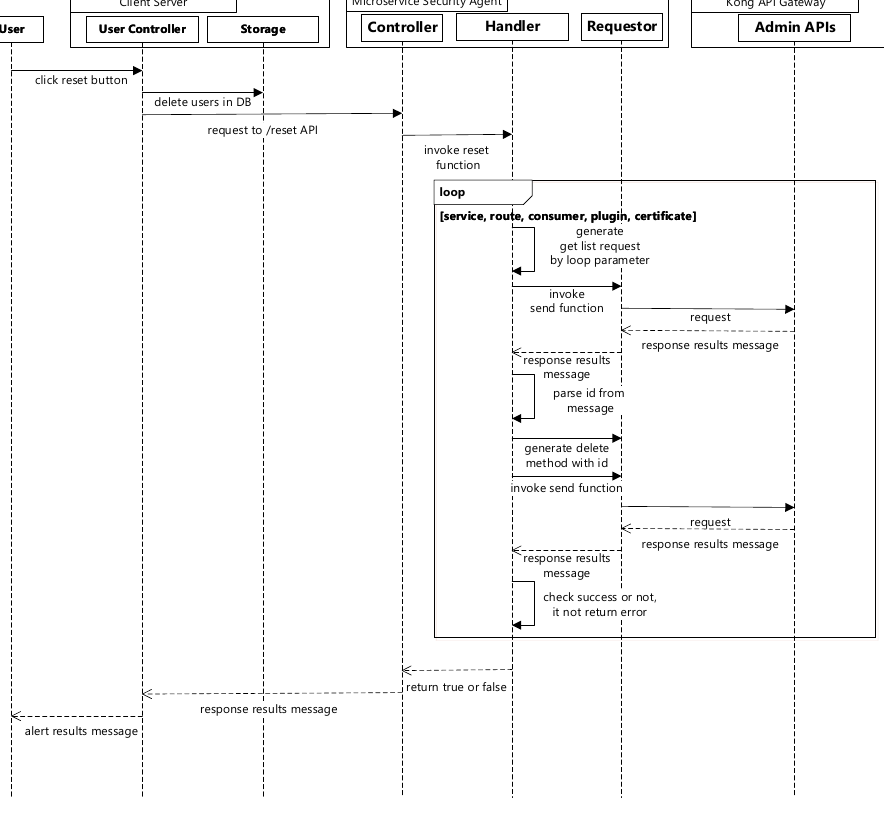
Figure 7. Reset sequence diagram for removing all the